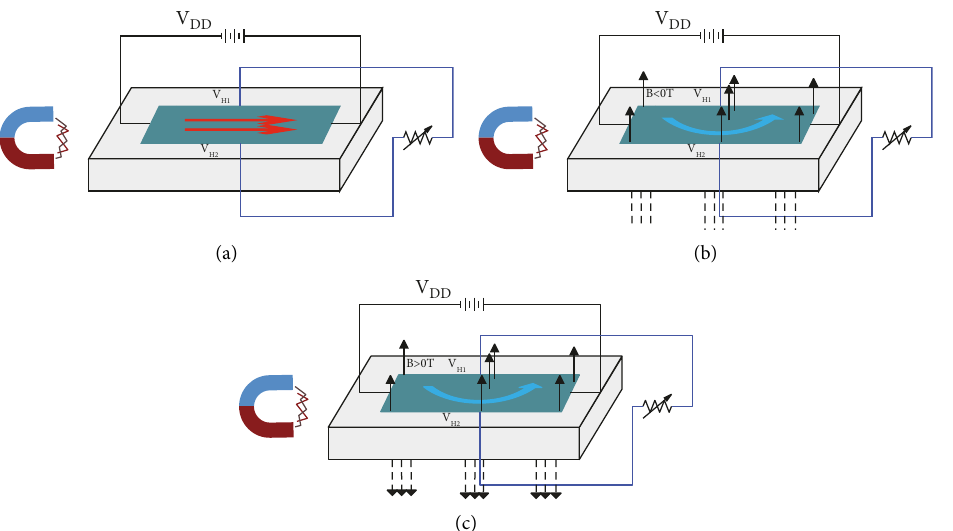
Figure 1: Schematic diagram of the working principle of magnetic field sensor: (a) B